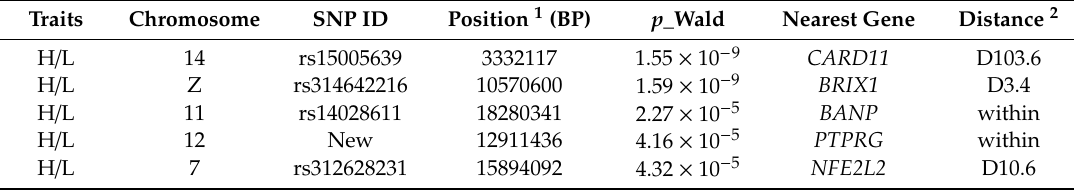
Table 2. Single nucleotide polymorphisms (SNPs) with genome-wide significance for H/L traits. Traits